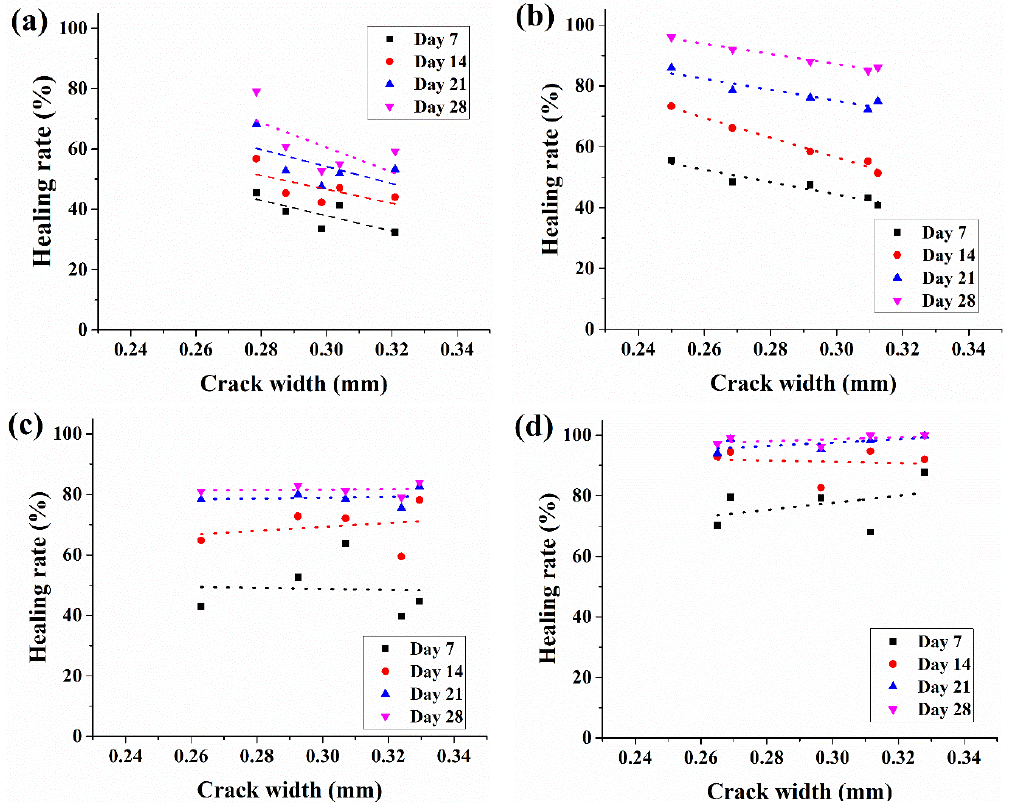
Figure 11. Water permeability through crack-induced mortar specimen: ( a ) RM, ( b ) BM, ( c ) EPM and ( d ) BPM . Figure 12 shows a crack photograph of a specimen subjected to a water penetration test. Figure 12a,b are BM and BPM of 0 days, respectively, showing that white crystals were formed on the surface of the specimen and near cracks as in figures c,d after 28 days. However, figure d covers most of the cracks compared to figure c.